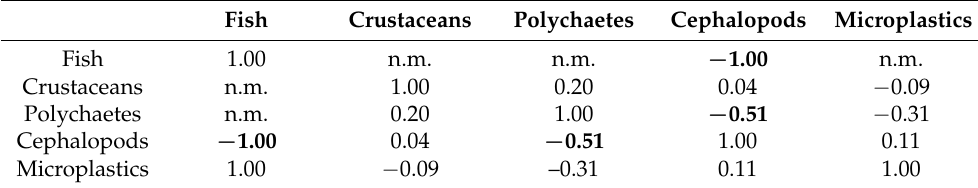
Table 3. Gamma non–parametric correlations between the five prey categories (microplastics in- cluded) at the macro taxa level found as number of items per stomach from a sample of the hollow– snout grenadier from the bathyal plane of the eastern central Tyrrhenian Sea. Bold values are significant p < 0.05 and n.m. stands for no match between data series concerned.